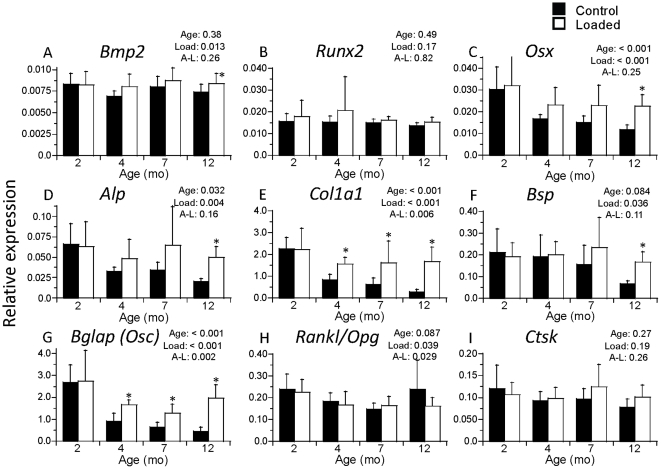
Mechanical loading upregulates bone genes in older mice.Bilateral tibias (left, Control; right, Loaded) were harvested after 1 week of unilateral mechanical loading. mRNA was isolated, quantified by real-time RT-PCR, normalized to the housekeeping gene cyclophilin, and then expressed as fold difference of loaded relative to control. There were no significant differences between loaded and control limbs at 2 months age. However, with increasing age there was an increase in relative expression of osteoblast and bone matrix genes in loaded versus control limbs. (n = 7–8; mean ± SD; p-values for Age, Load and Age-Load interaction are from 2-factor ANOVA; * loaded different from control, p<0.05).